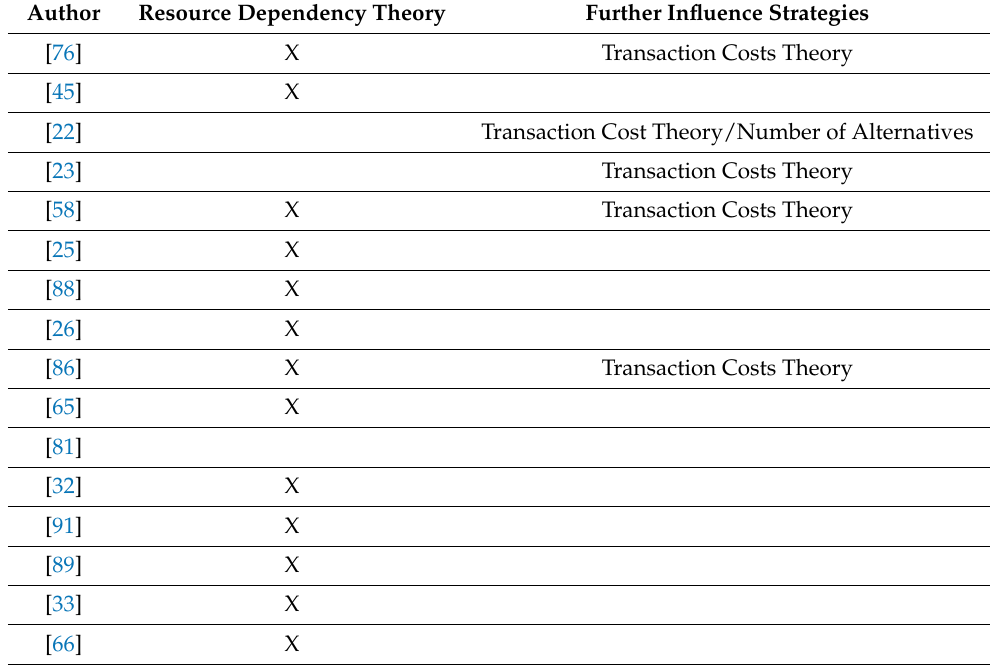
Table A2. Influence mechanisms and strategies of